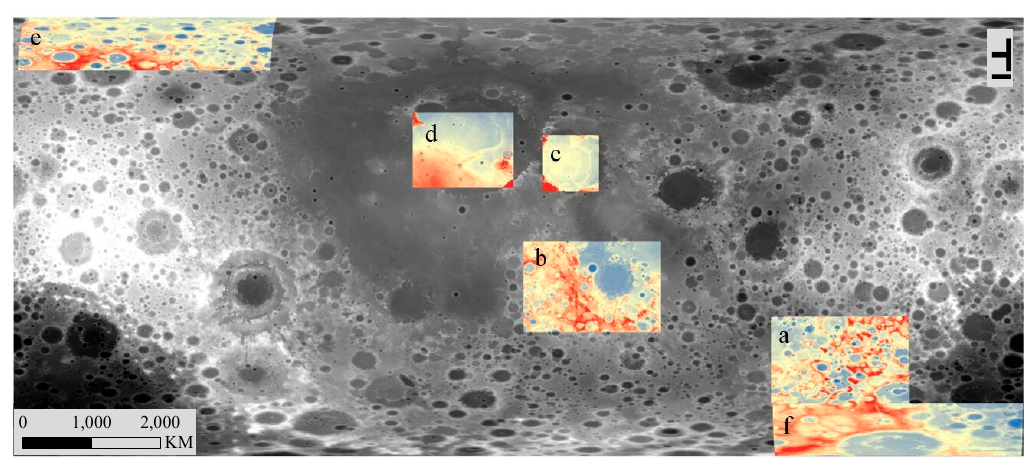
Figure 16. Experimental areas for the heterogeneity analysis case study. These areas are located in: ( a ) Highland (far side); ( b ) Highland (near side); ( c ) Mare Serenitatis; ( d ) Mare Imbrium; ( e ) North Pole; and ( f ) South Pole.